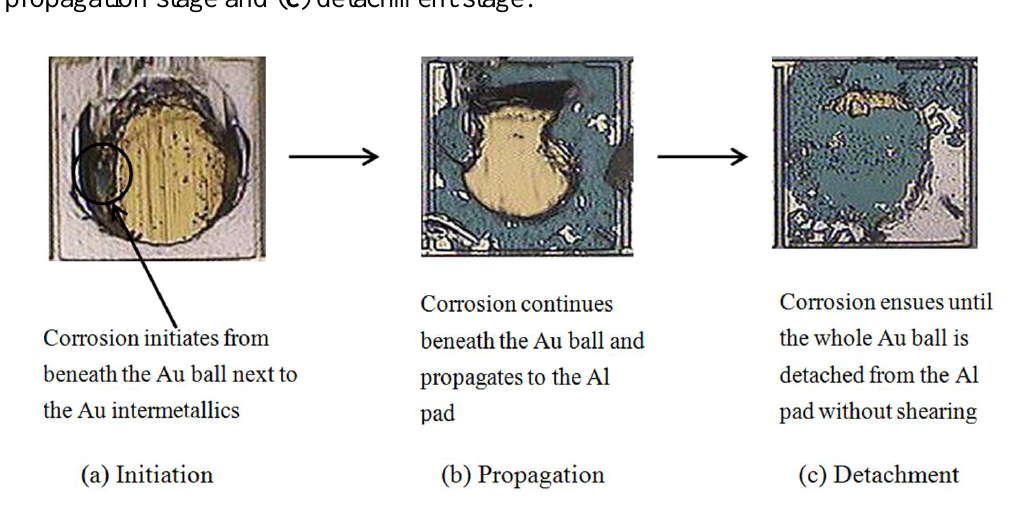
Figure 3. Corrosion mechanism of Au balls and Al pad at the ( a ) initiation stage; ( b ) propagation stage and ( c ) detachment